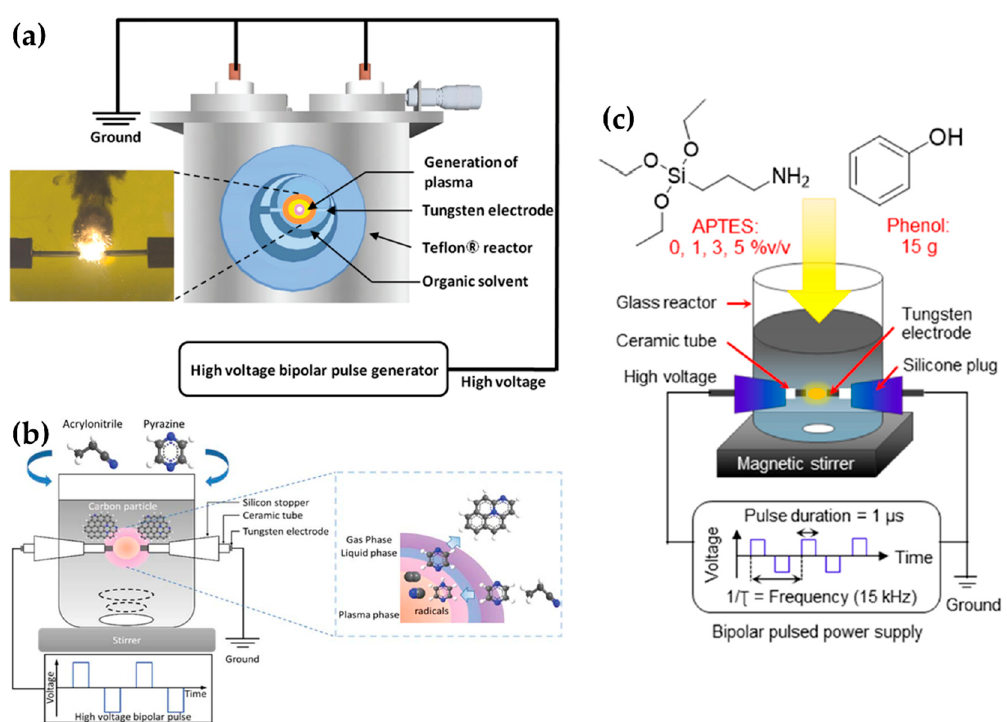
Figure 11. Schematics of generation of the in-solution plasma systems of ( a ) Lee et al. [107], ( b ) Li et al. [108], and ( c ) Tipplook et al. [109].